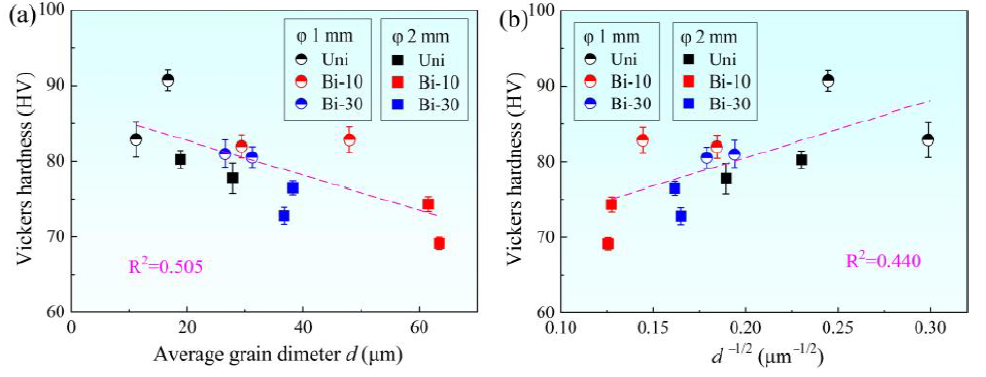
Figure 7. Relationship between Vickers hardness with ( a ) d and ( b ) d − 1/2 .